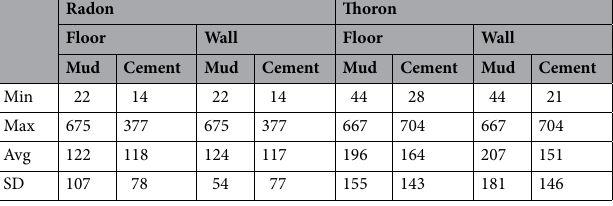
Table 2. The activity concentration of radon ( 222 Rn) and thoron ( 220 Rn) (Bq m −3 ).